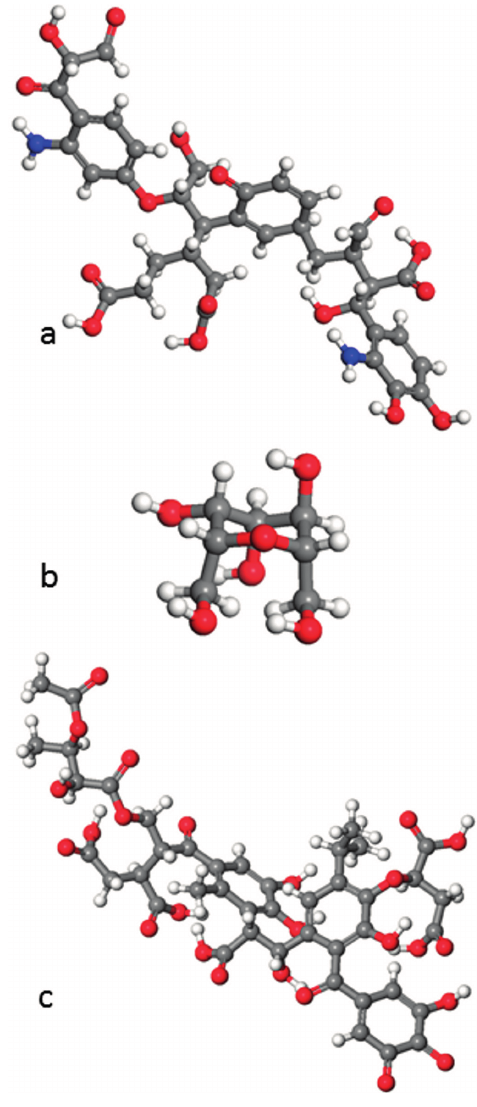
Figure 4. Repeating units of proposed natural organic matter (NOM) models: ( a ) Temple-Northeastern-Birmingham (TNB) [86]; ( b ) lignin-carboxylate complex [104]; and ( c ) cutin-lignin-tannin complex [106]. Atoms are colored as followed: C (gray), H (white), O (red), N